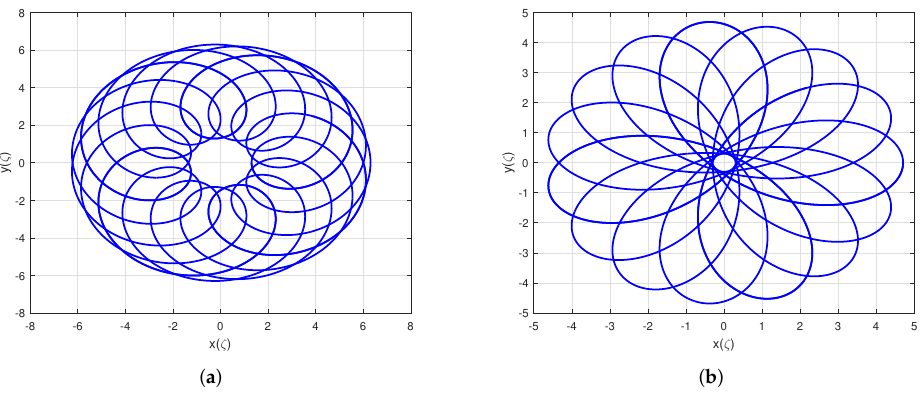
Figure 11. Epitrochoid and hypotrochoid spirals for ρ 1 = 0.8, ρ 2 = 3, and d = 2.5: ( a ) epitrochoid spiral and ( b ) hypotrochoid